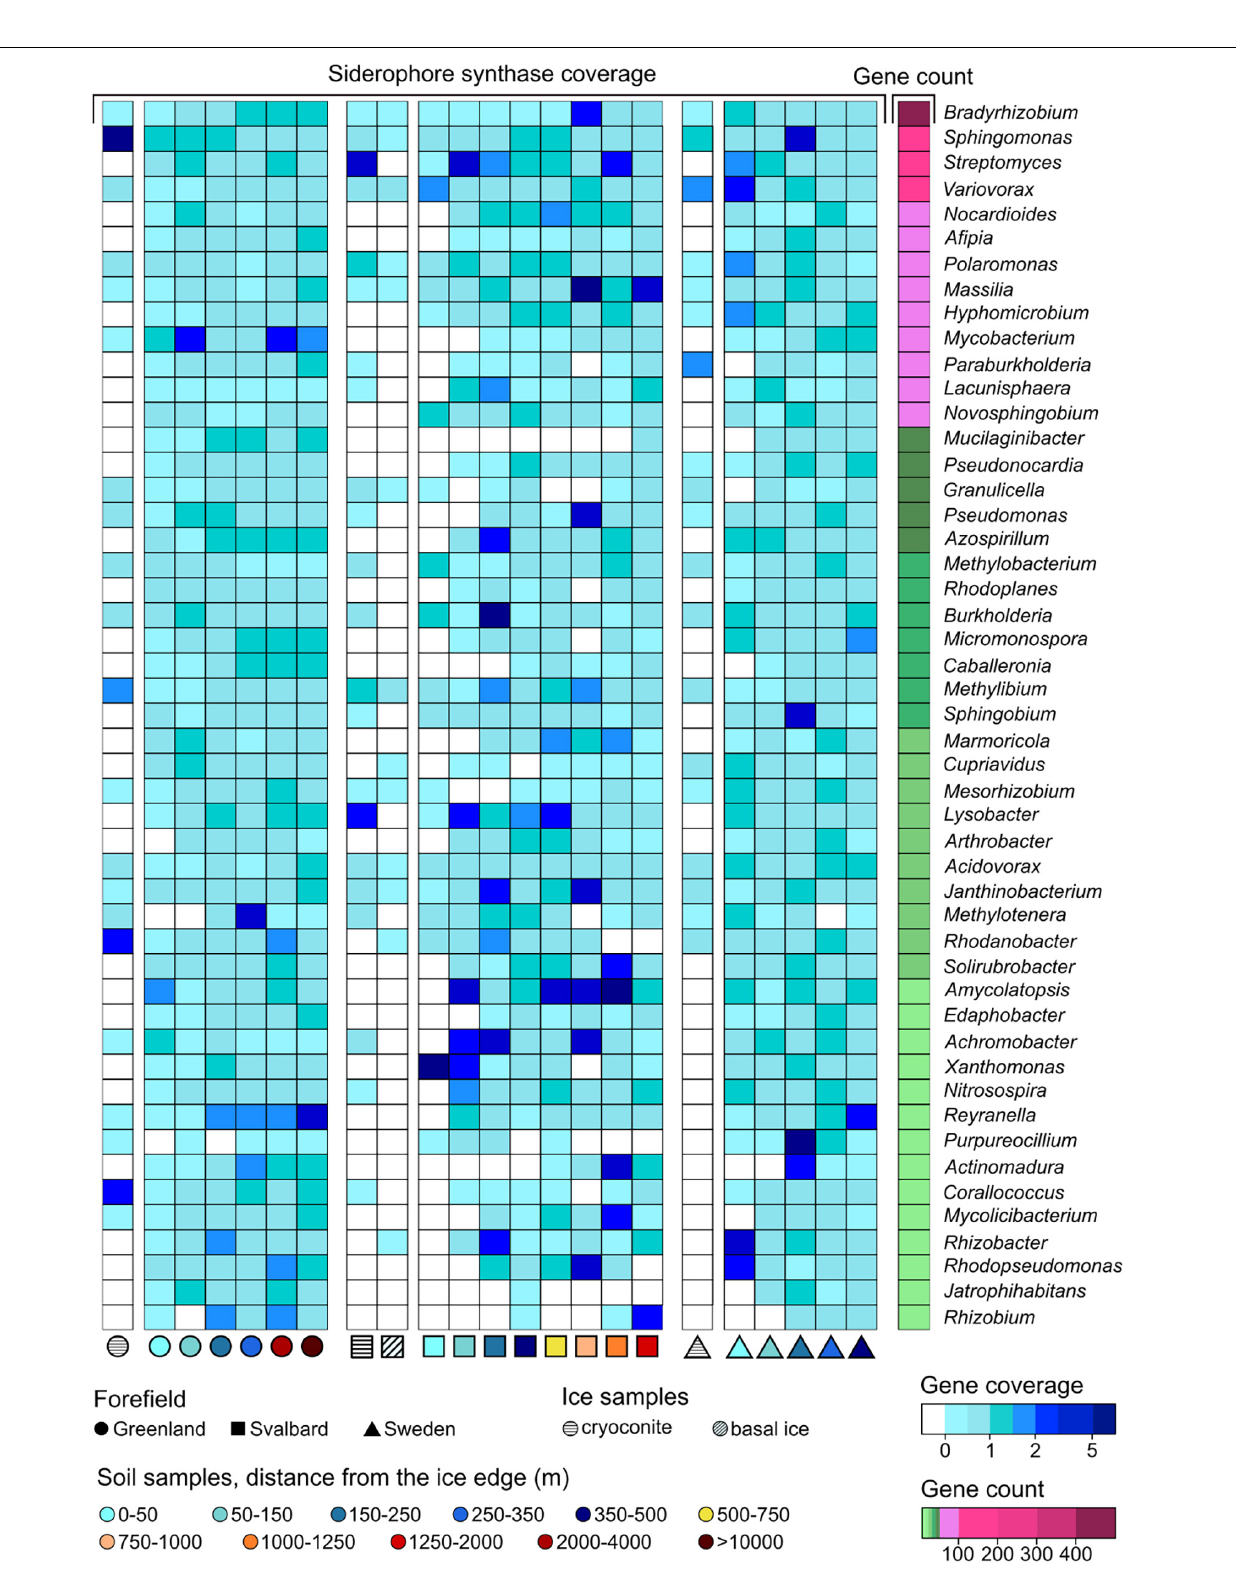
Frontiers in Microbiology |